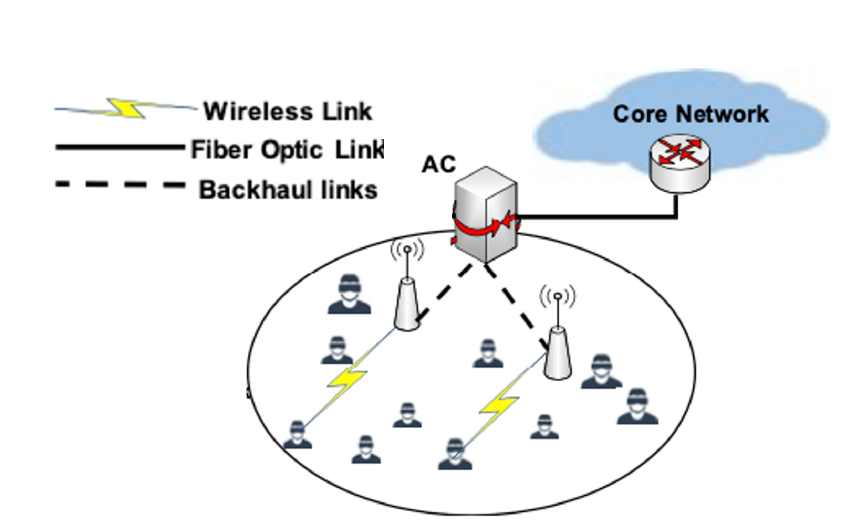
Figure 2. Edge Network